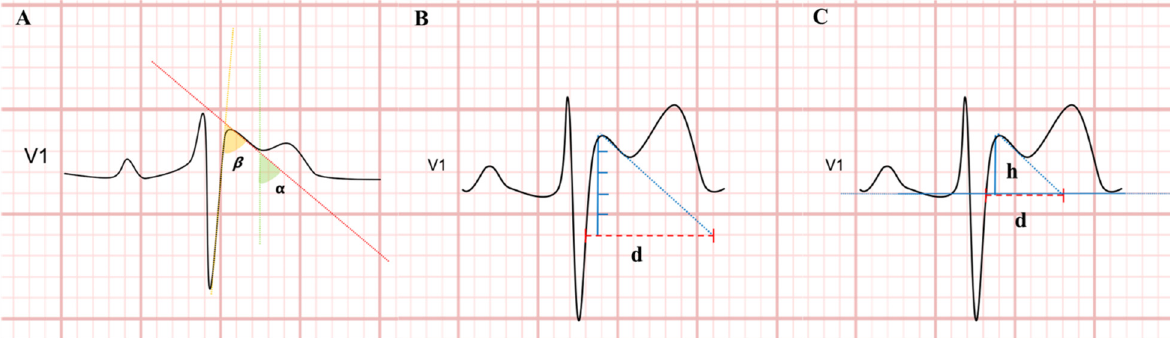
Figure 1. Measurement of β -angle and α -angle ( A ); duration of the base of the triangle at 5 mm from the r ′ -wave ( B ); duration of the base of the triangle at the isoelectric line and triangle base/height ratio ( C ).